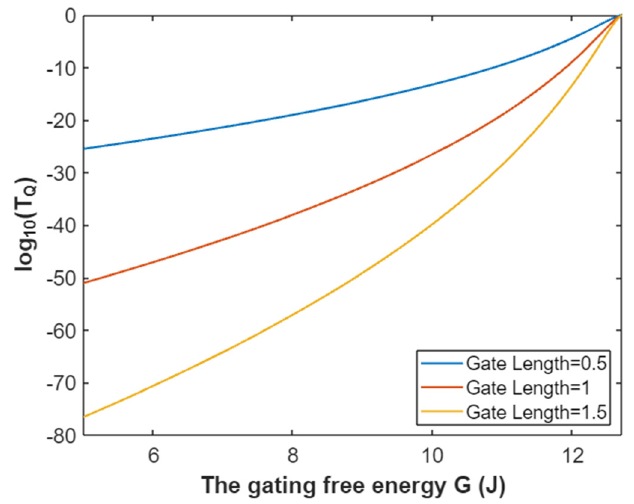
Figure 24. The relationship between gating free energy and the common logarithm of tunneling probability of intracellular potassium ions at membrane potential of 0.087 V and over a gating free energy range from 5 J to 12.72 J.